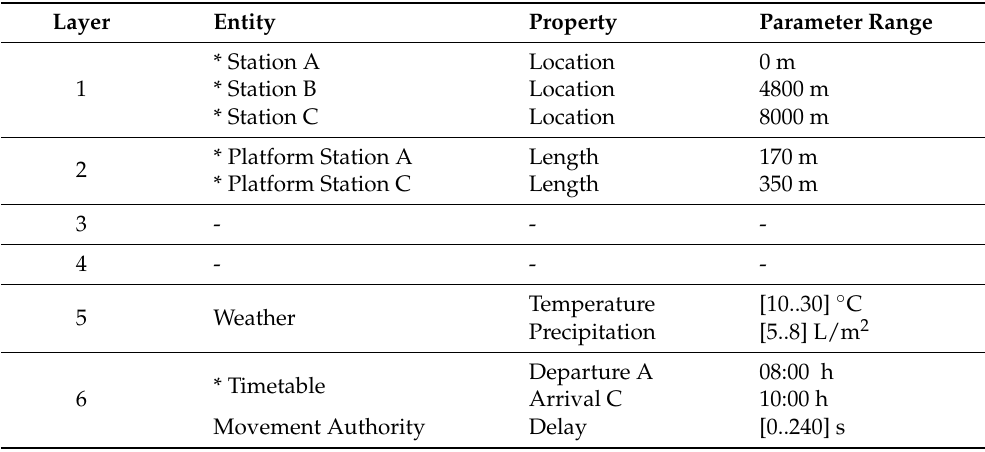
Table 3. Definition of entities and their properties of an exemplary logical scenario for a train journey based on the description of a simple functional scenario. Elements marked with an asterisk (*) do already have finalized values and are part of the base scenario, showcasing the difference between a base and a logical